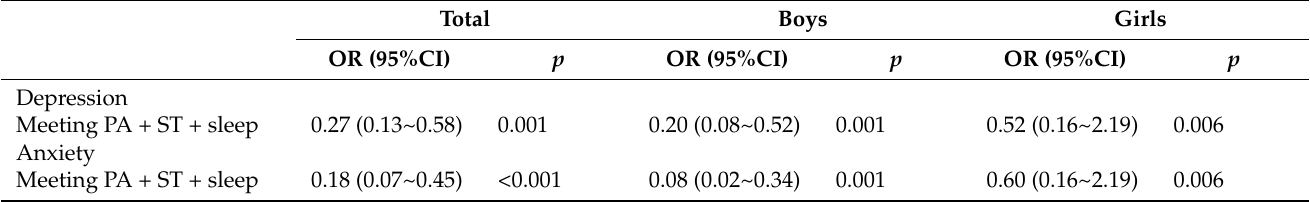
Table 5. Meeting three recommendations of the 24-HMG in relation to anxiety and depression in the